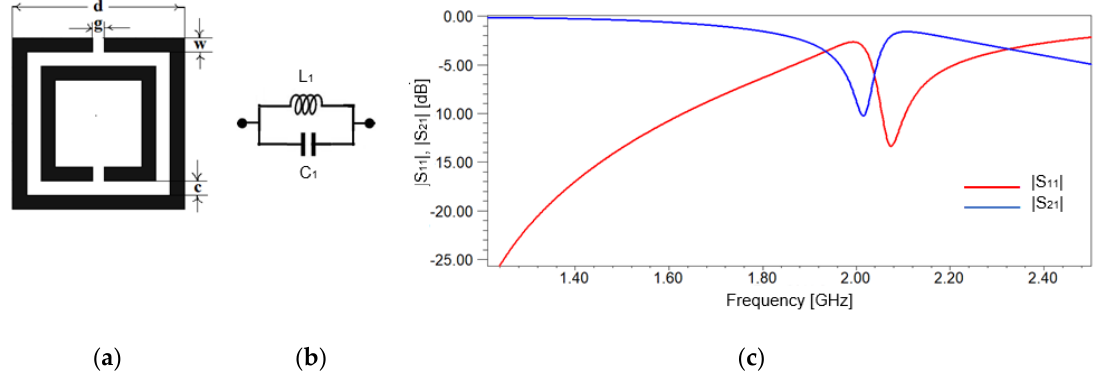
Figure 1. Split Ring Resonator: ( a ) Split Ring Resonator (SRR) with physical dimensions; ( b ) equivalent circuit; ( c ) frequency response of the scattering parameters for SRR.